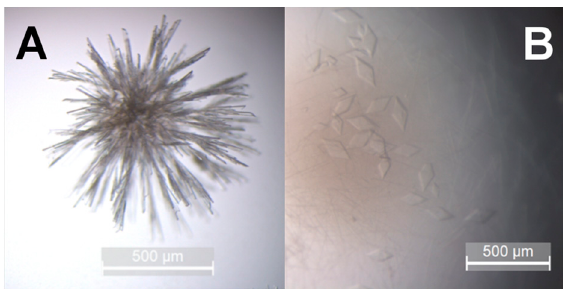
Figure 5. Crystals of hBChE-7. Crystallization was realized by the hanging drop method using 0.2 M NH 4 OAc pH 7.4 and 20% polyethylene glycol (PEG) 3350 as precipitation solution. hBhE-7 at a concentration of 2 mg mL − 1 was mixed 2:1 with the precipitation solution. ( A ) crystals grown at 20 °C; ( B ) crystals grown at 4 °C.